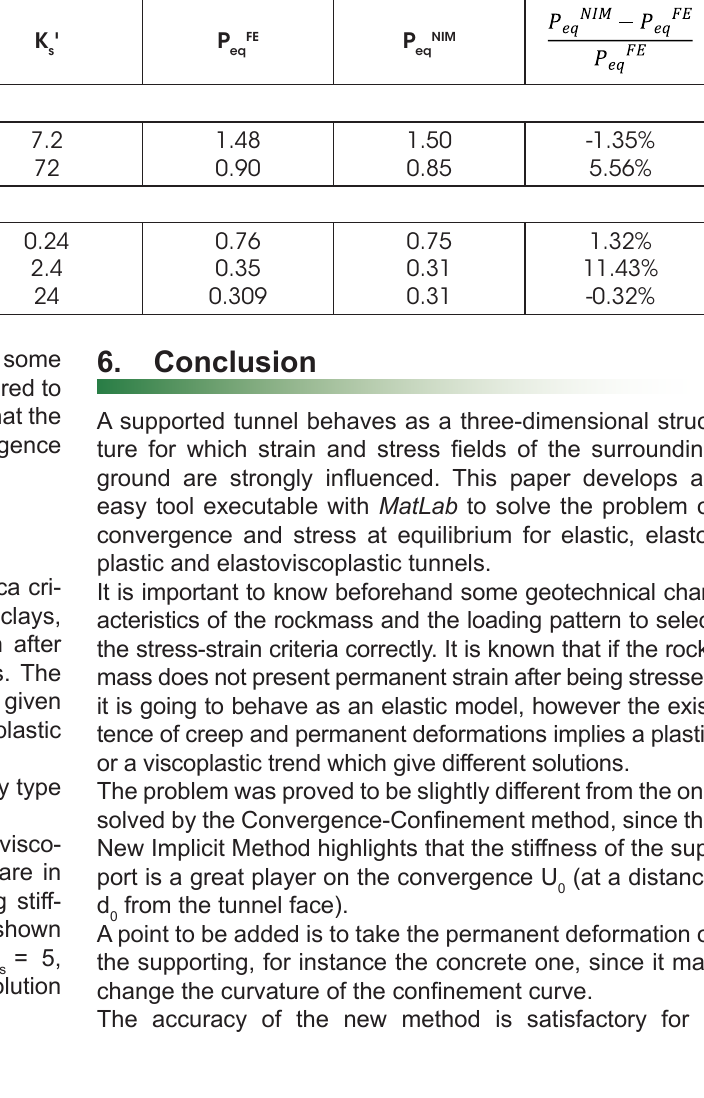
Table 3 Validity of the method for viscoplastic rockmass N